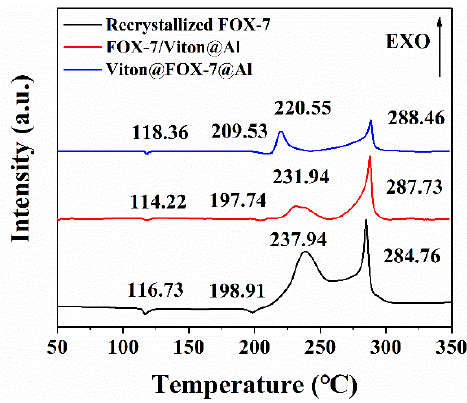
Figure 6. DSC curves of recrystallized FOX-7, FOX-7/Viton@Al and Viton@FOX-7@Al under the heating rate of 5 °C·min − 1 .